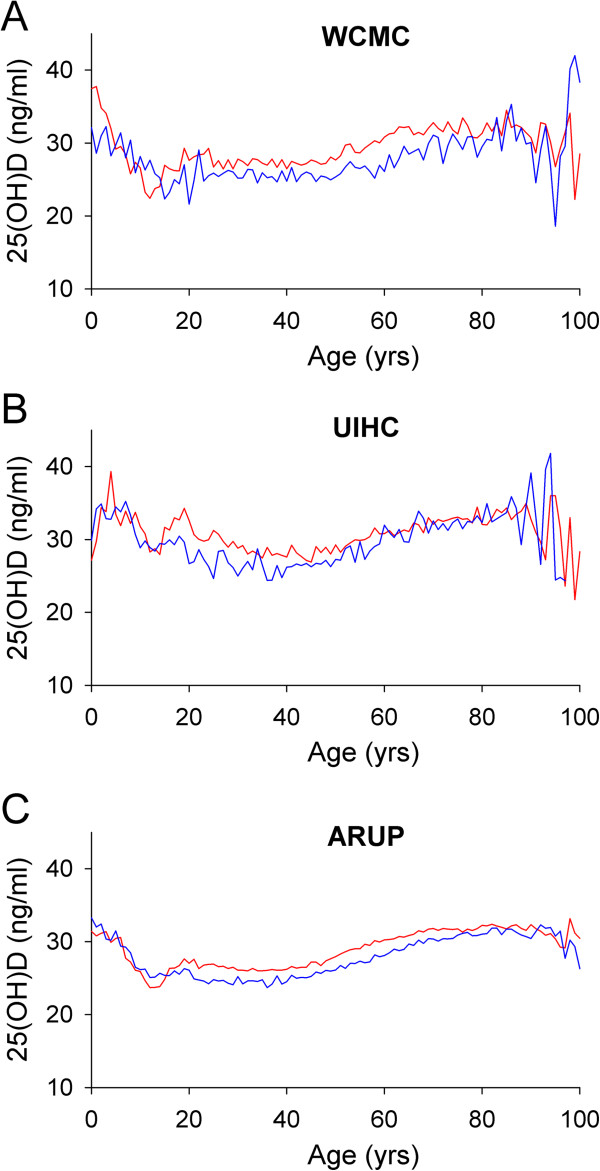
25(OH)D immunoassay – average concentration by age and sex – results for all ages. Average 25(OH)D results at WCMC (A), UIHC (B), and ARUP (C) by age and sex (female = red lines; male = blue lines). Variability at young and old ages (particularly A and B) may be due to comparatively small n-values (see Figure 1C,D).